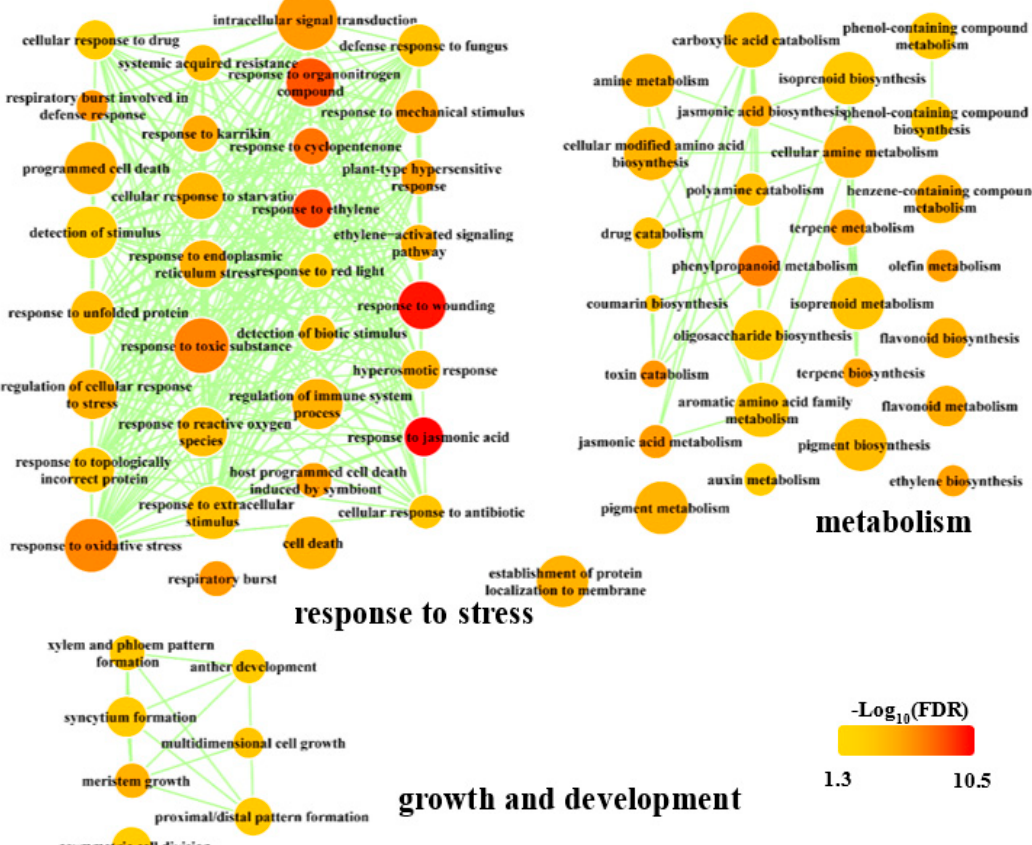
Figure 2. Significantly enriched gene ontology (GO) terms in biological process. The results were obtained in R using the “clusterProfiler” package, reduced with REVIGO (http://revigo.irb.hr/) and visualized in Cytoscape. The color indicated the significance of GO terms, and node size represented the frequency of the GO term. Only significant GO terms were shown. FDR, false discovery rate.